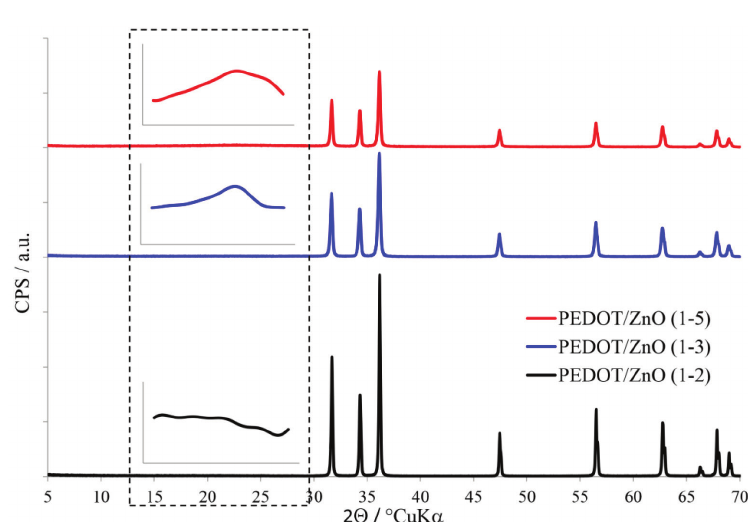
Fig. 8 – XRD diffractograms of PEDOT/ZnO samples synthesized at various monomer to APS oxidant ratio (1:2, 1:3,